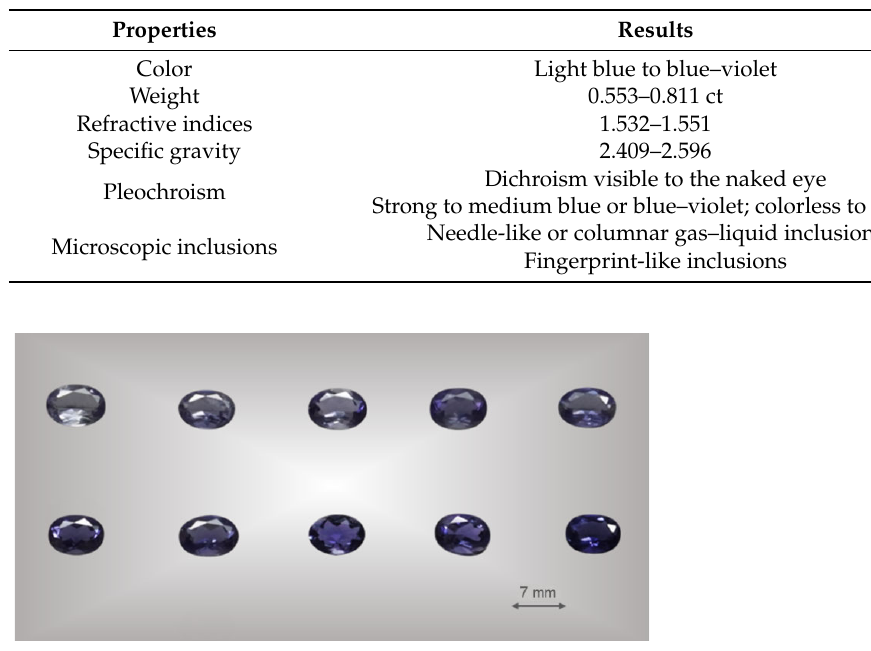
Table 1. Gemological properties of iolite samples.